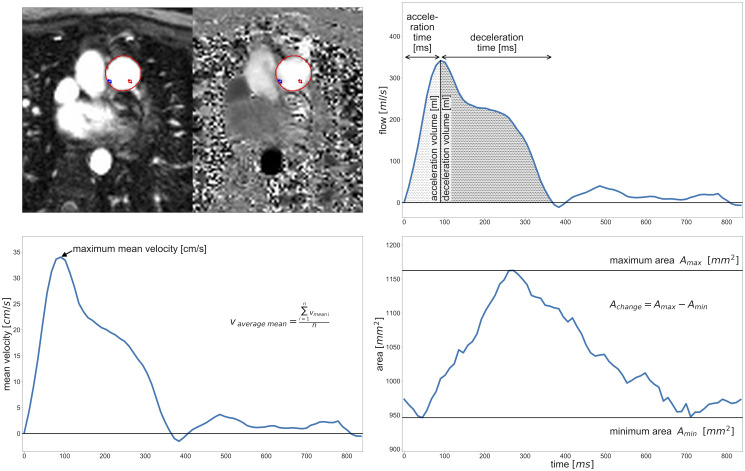
Through-plane two-dimensional phase-contrast measurement in the main pulmonary artery.Illustration of parameters derived from a phase-contrast measurement in the main pulmonary artery as defined by the region of interest in the first image. vaverage mean = average mean velocity, Achange = area change. Amax = maximum area, Amin = minimum area.